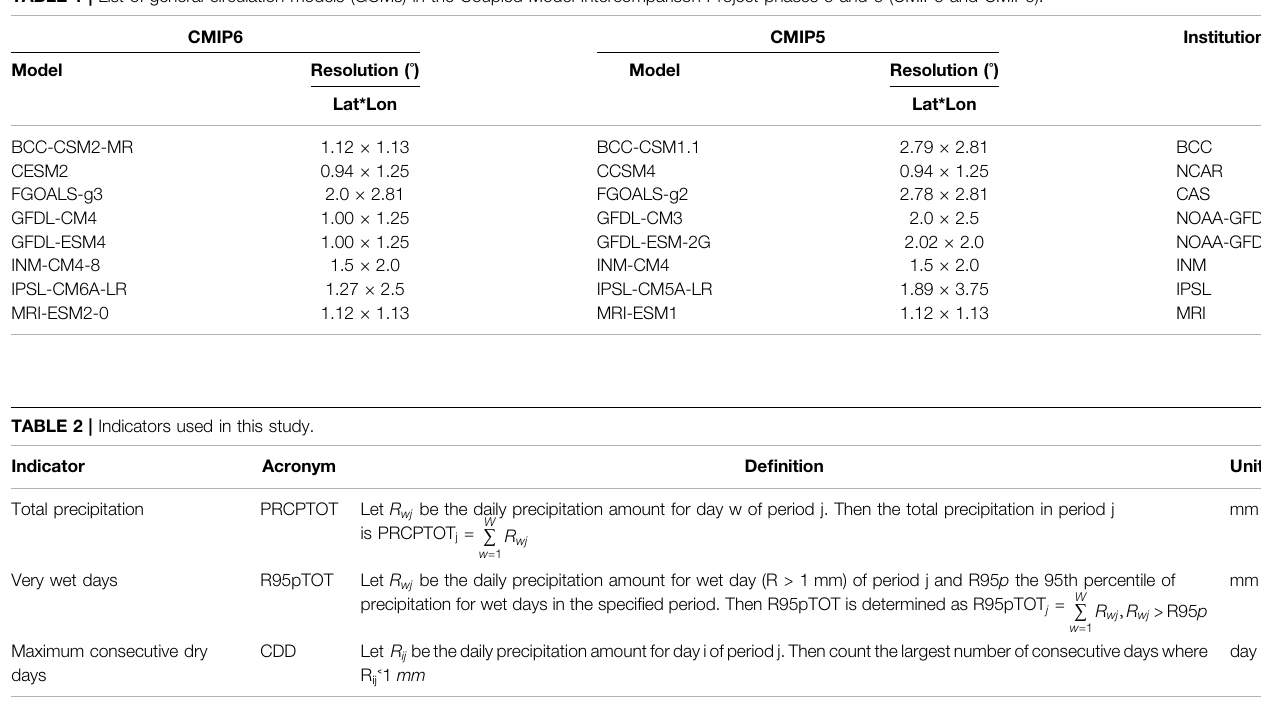
TABLE 1 | List of general circulation models (GCMs) in the Coupled Model Intercomparison Project phases 5 and 6 (CMIP5 and CMIP6).